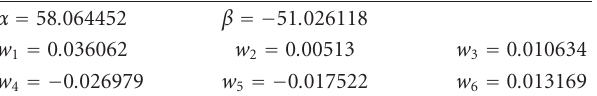
Table 2: Method parameters and weighting factors (MOS scale, 1 to